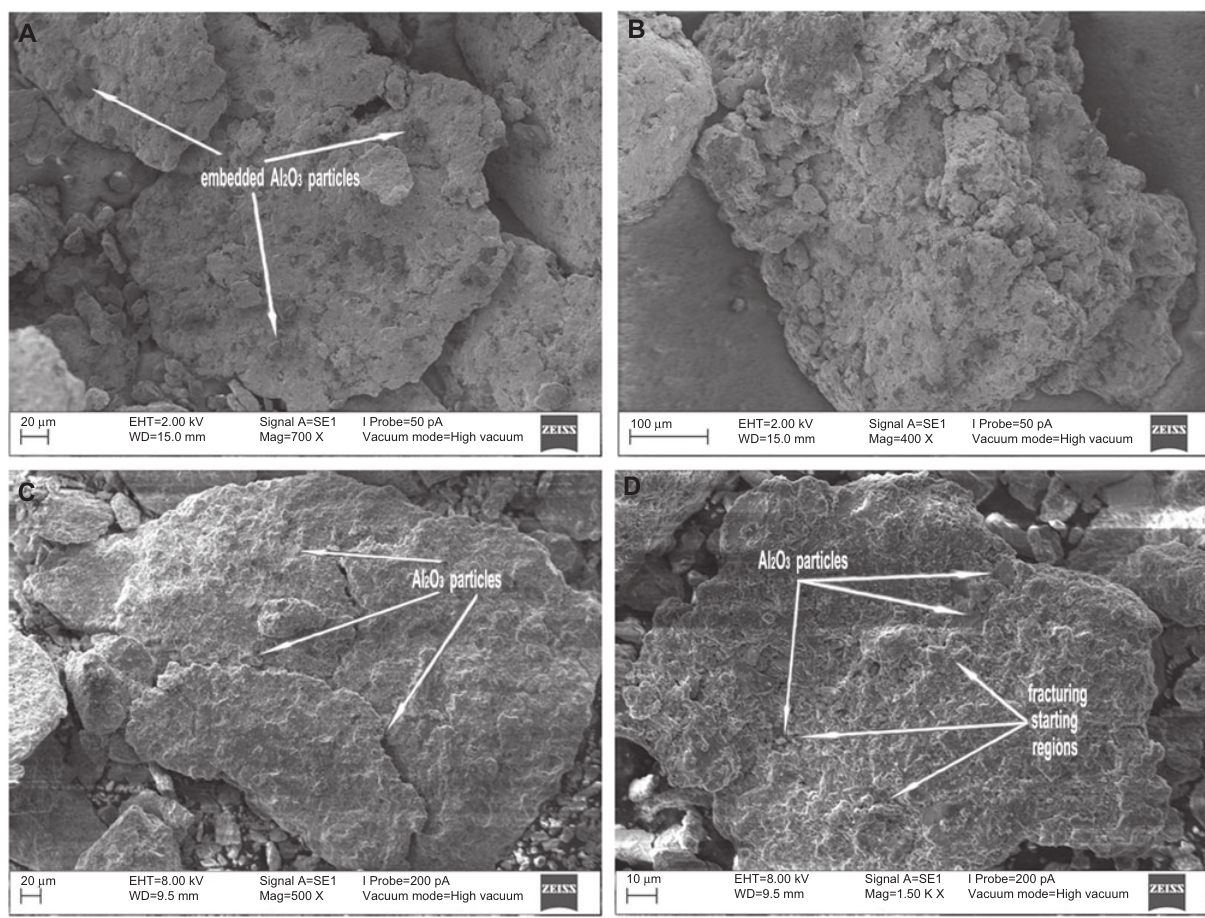
Figure 7 Several morphologies of mechanically alloyed 10 vol. % Al ded sample), (C) 0.5 h (fracturing sample), (D) 2 h (fracturing sample).